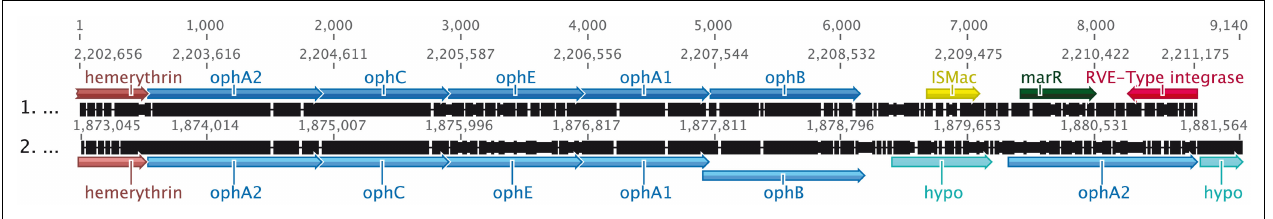
the original source of that sequence. Colors indicate oph genes (light blue), transposons (yellow), integrases (red), regulatory elements (dark green), hemerythrin (brown), and genes for hypothetical proteins (turquoise). Reactions catalyzed by oph gene products are summarized in Figure 3